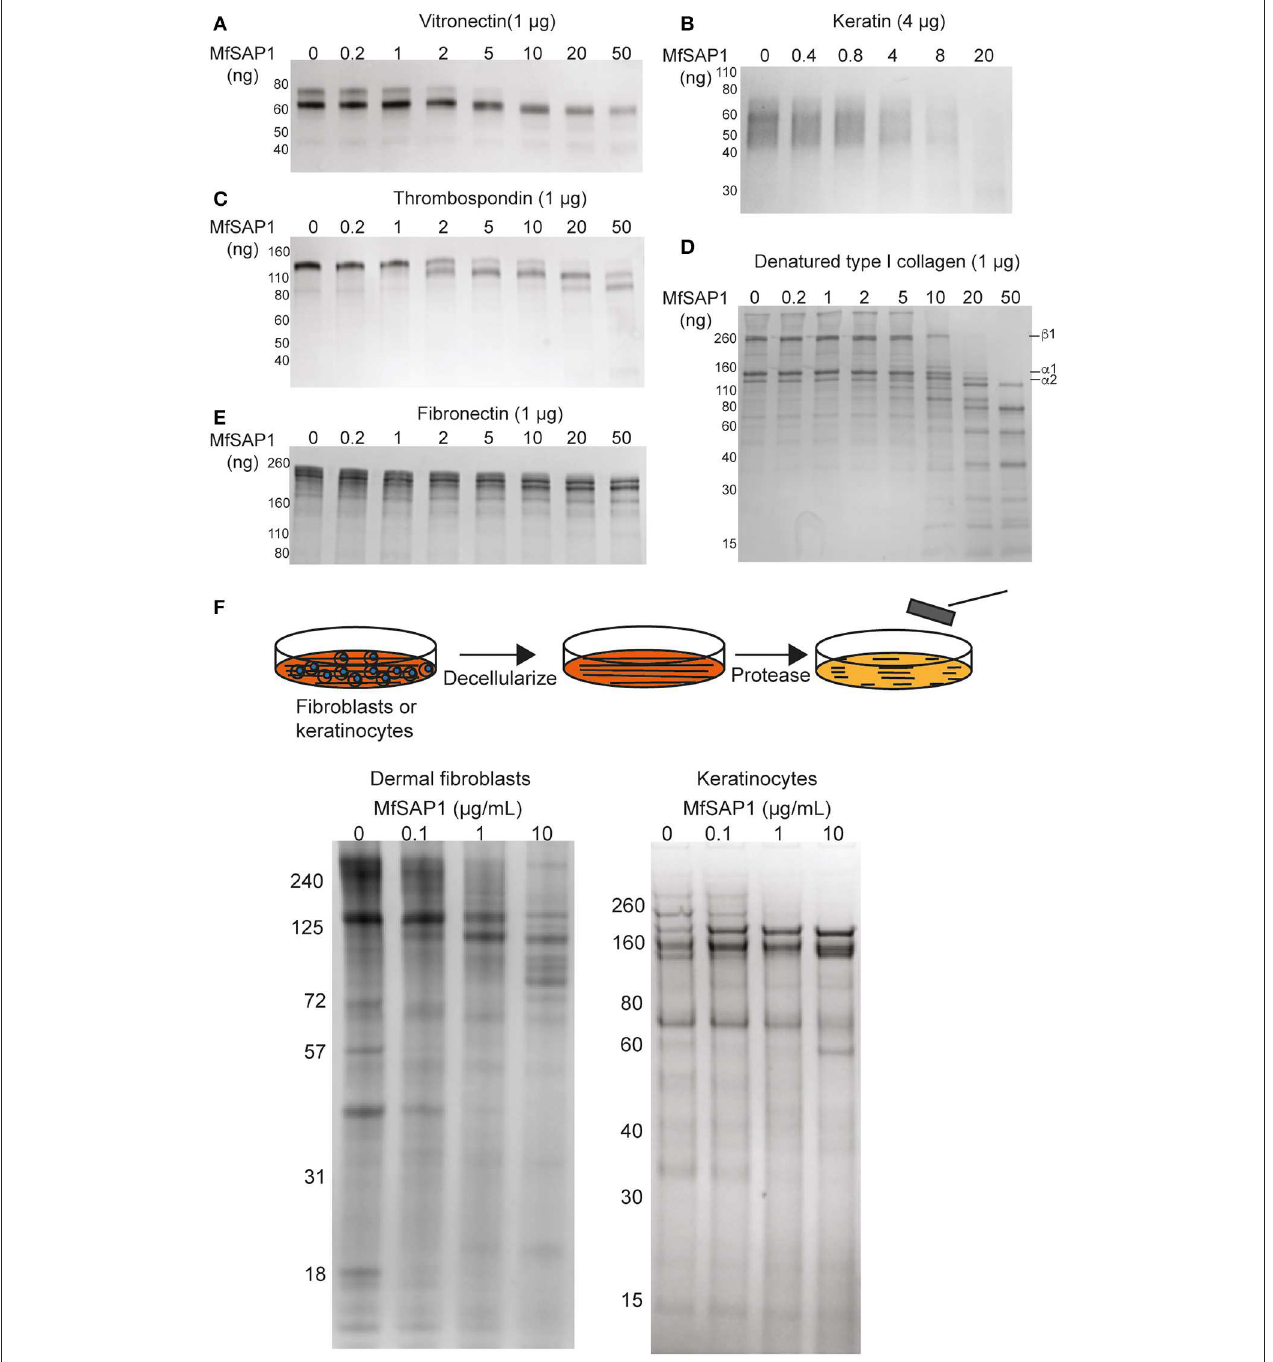
FIGURE 3 | MfSAP1 degrades human extracellular matrix proteins. (A–E) ECM protein degradation, as assessed by SDS-PAGE, after MfSAP1 was incubated with each purified ECM protein at varying substrate to enzyme ratios. (F) Cartoon of the decellularization and protease treatment (top). Degradation of whole dermal fibroblast (left) and keratinocyte (right) ECM at different MfSAP1 concentrations by SDS-PAGE analysis. Representative SDS-PAGE images are shown for a total of at least 2 independent